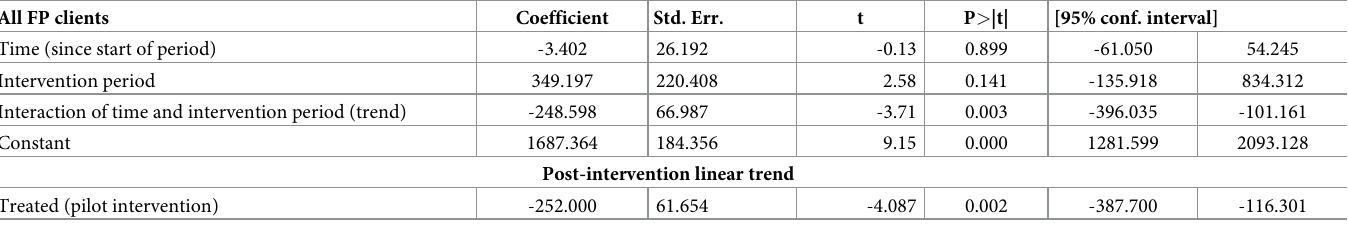
Table 8. Results of interrupted time series regression, monthly totals of all FP clients in the ten pilot intervention facilities from September 2017 to November 2018, Tanzania 2018. All FP